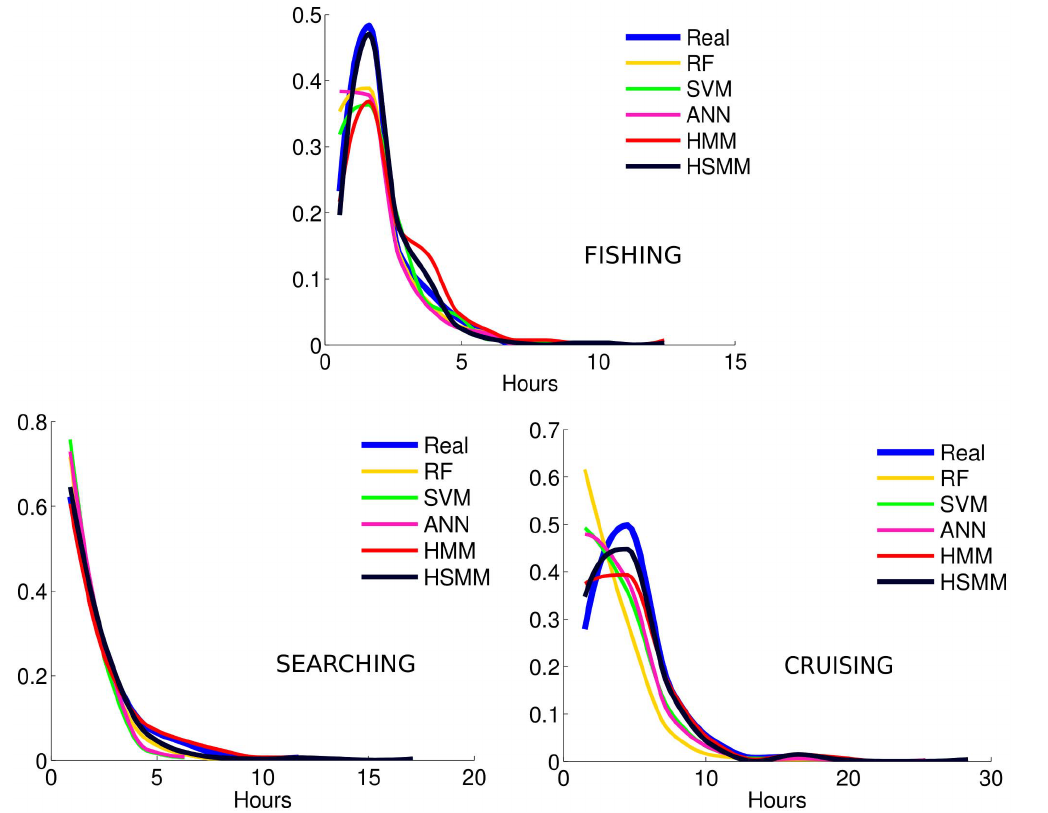
Figure 3. Distribution of the duration of each behavioural mode. For each model, an empirical distribution of the duration of each mode is estimated based on the duration of all inferred segments encoding the mode. RF: random forest. SVM: support vector machine. ANN: artificial neural network. HMM: hidden Markov model. HSMM: hidden semi-Markov model. Real: known behavioural modes.